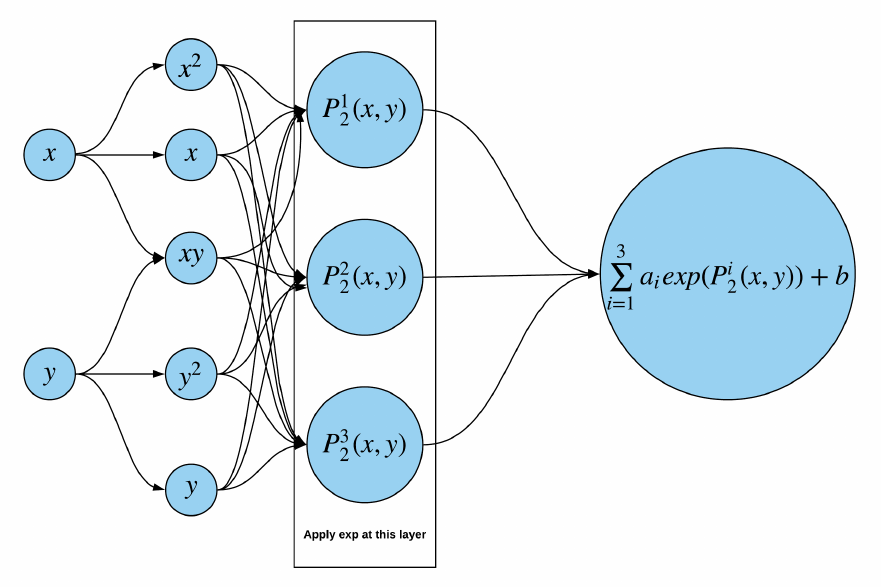
Figure 1. Sum of exponential network